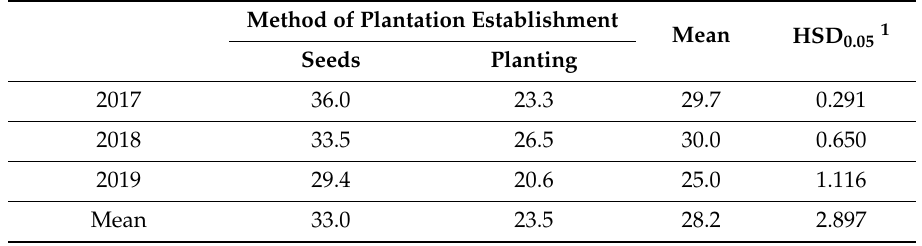
Table 6. The number of shoots per 1 m 2 of Silphium , depending on methods of plantation establishment. Method of Plantation